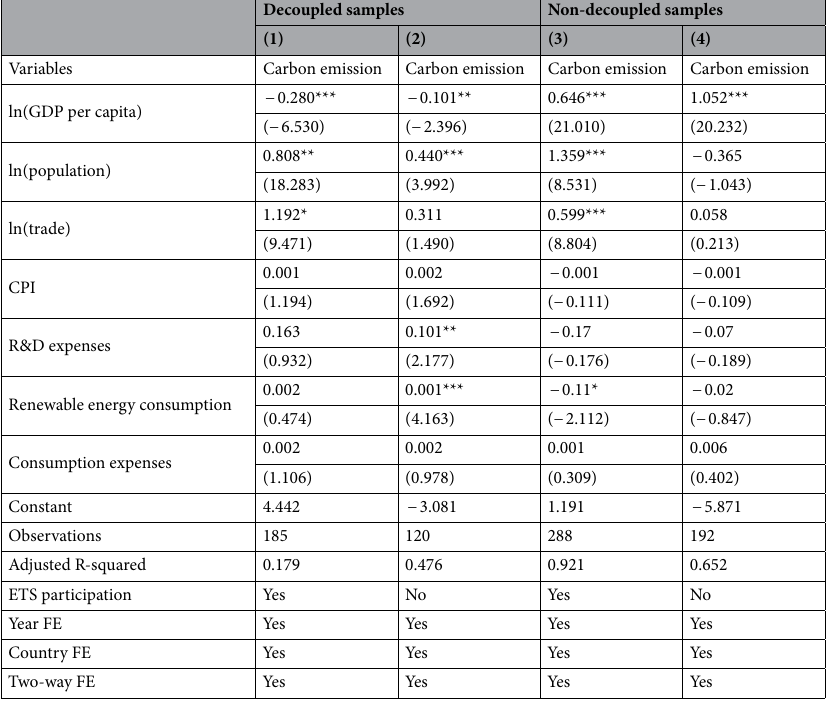
Table 3. Regression results examining the ETS effects on the relationship between economic development and carbon emissions. Columns (1) and (3) provide the estimation results for ETS participating countries that are decoupled and non-decoupled, respectively. Columns (2) and (4) show the results for non-ETS participants that are decoupled and non-decoupled,